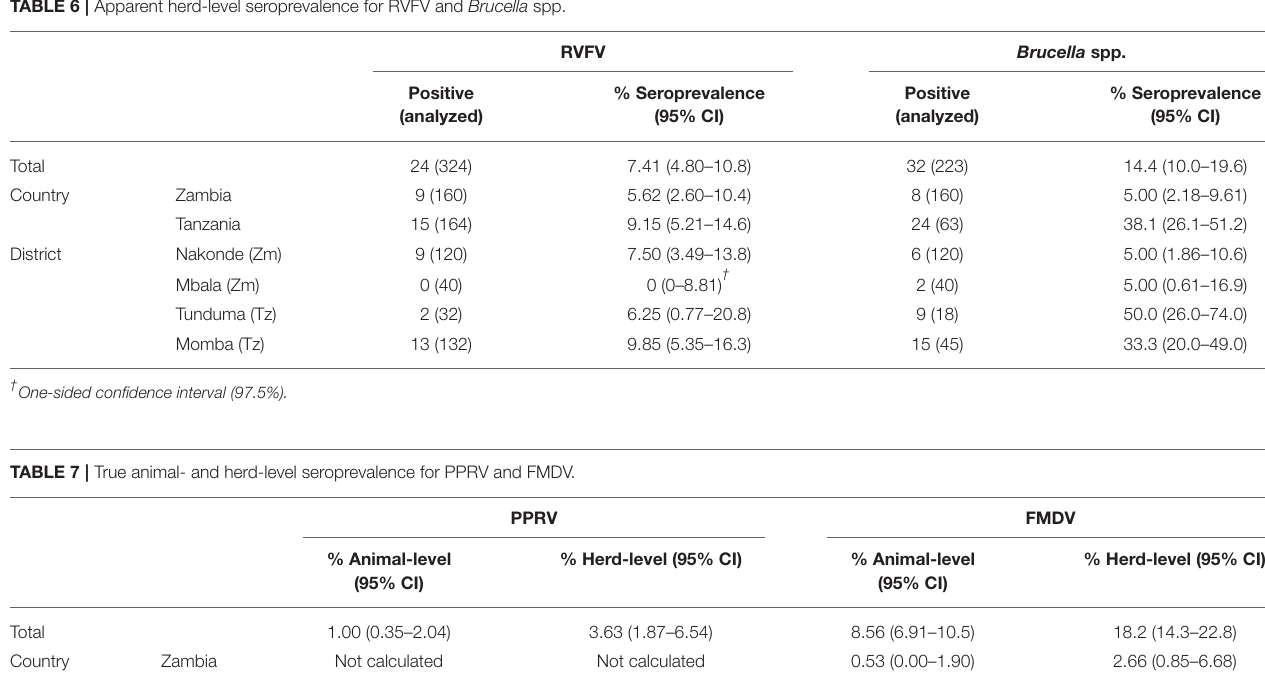
TABLE 6 | Apparent herd-level seroprevalence for RVFV and Brucella spp.